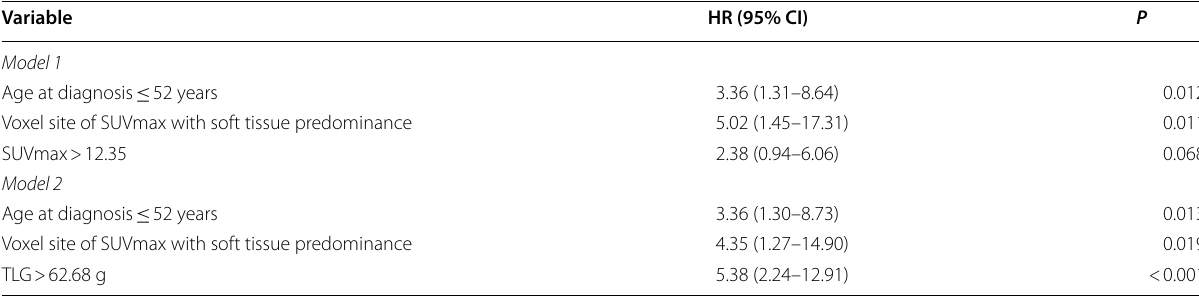
Table 2 Multivariable Cox regression analysis of mandibular relapse‑free survival